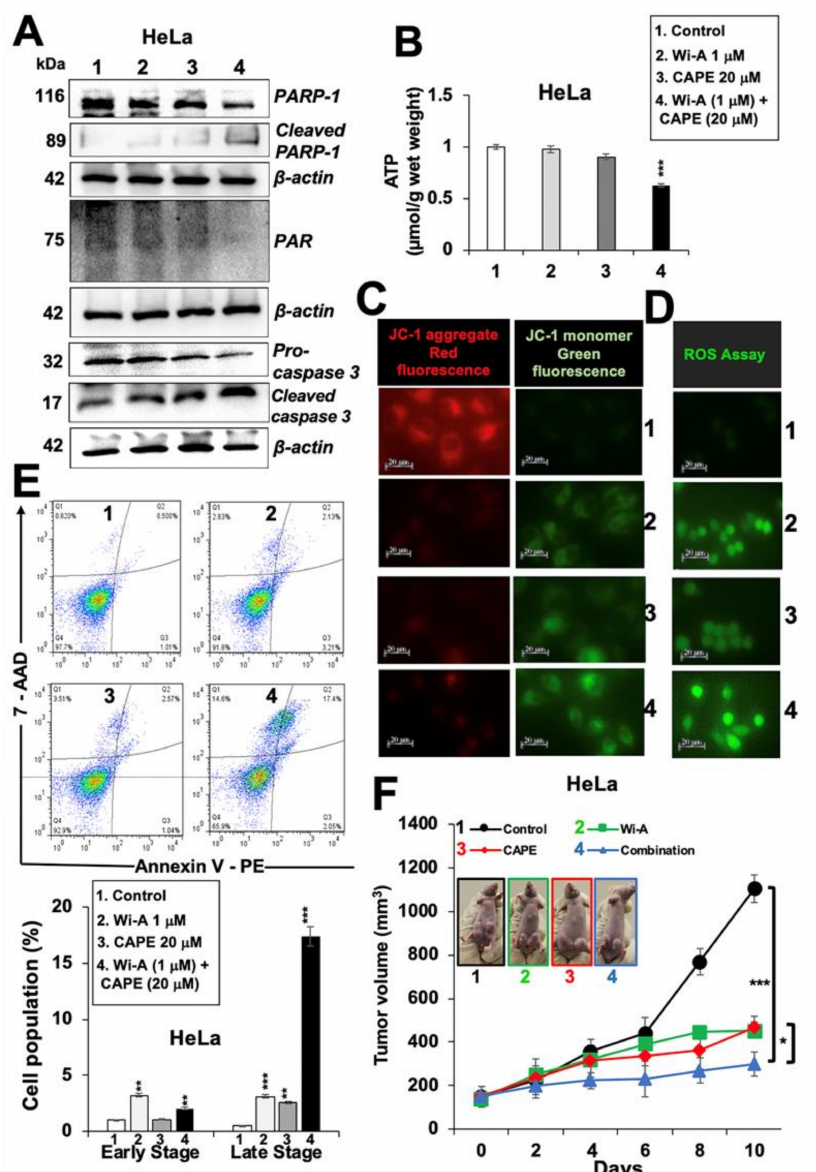
Figure 5. Withaferin A (Wi-A) and ca ff eic acid phenethyl ester (CAPE) in combination caused stronger activation of apoptosis signaling. ( A ) Western blot analysis of Wi-A, CAPE, and their combination treated cells showing stronger decrease in poly ADP-ribose polymerase1 (PARP1), poly (ADP-ribose) polymerase (PAR), and Pro-caspase 3 levels in the latter ( A ). Whereas Wi-A- and CAPE-treated cells did not show decrease in adinosine triphosphate (ATP) levels, the combination showed decrease ( B ). Wi-A, CAPE, and their combination treatment showed lower mitochondrial membrane potential as detected by JC-1 staining ( C ); Scale bar–20 µ M and increase in oxidative stress as detected by reactive oxygen species (ROS) ( D ); Scale bar–20 µ M. Flow cytometric analysis showing increase in apoptotic cells when treated with the combination as compared to either Wi-A or CAPE alone ( E ); quantification of E is shown below. E ff ect of Wi-A, CAPE, and their combination on tumor growth of subcutaneous xenografts revealed strong suppression achieved by the later ( F ). Each data set represents the mean ± SD for at least three independent biological replicates. Statistical significance was defined as p -values (*) where * < 0.05, ** < 0.01 and *** < 0.001 represent significant, very significant and highly significant,